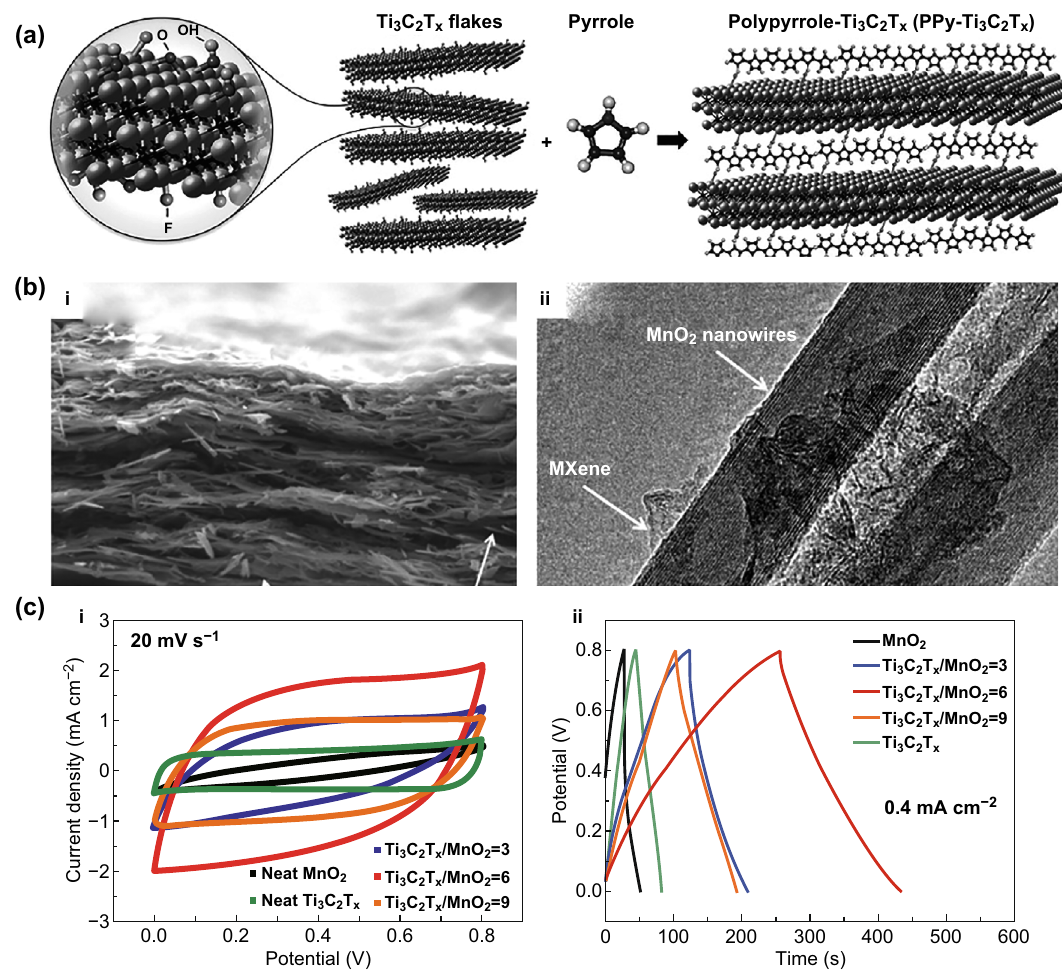
Fig. 7 Ti 3 C 2 T x composited with PPy and MnO 2 . a Schematic illustration of pyrrole polymerization using Ti 3 C 2 T x . The surface groups on the latter contribute to the polymerization process [99]. b Cross-sectional SEM image, and TEM image of Ti 3 C 2 T x /MnO 2 nanowires. c CV and GCD curves for different samples about Ti 3 C 2 T x /MnO 2 nanowires [104]. Reproduced with permission from Refs. [99,